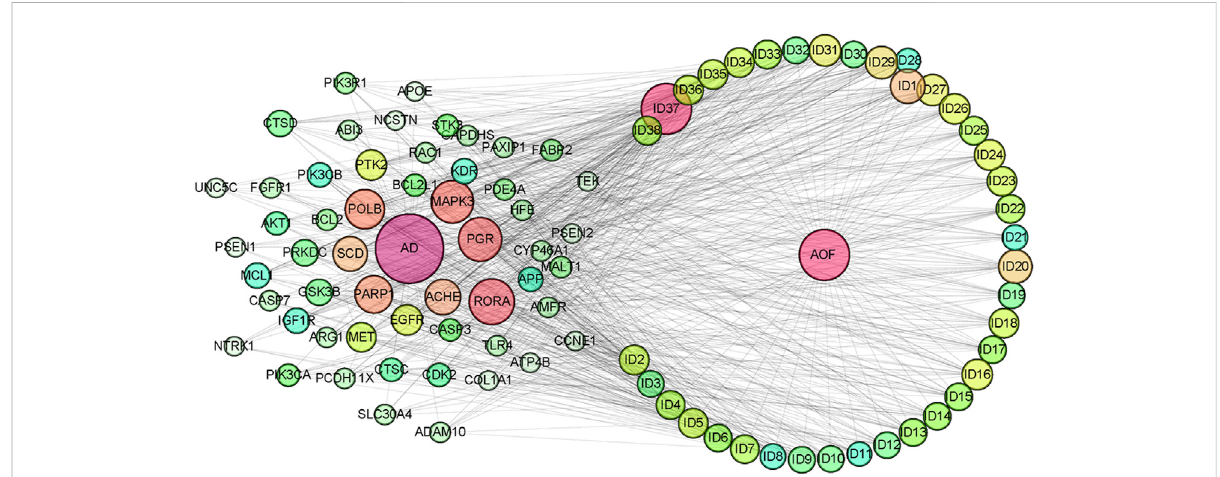
FIGURE 5 Network analysis of potential active compounds in AOF and AD targets. The drug, active compounds, disease and targets were input into Cytoscape to construct the DMTD diagram, and the colors of the nodes are illustrated from red to green in descending order of degree values (ID1: Protocatechuicacid;ID2:OxyphyllaneneA;ID3:OxyphyllenodiolA;ID4:OxyphyllenoneA;ID5:OxyphyllenoneB;ID6:(11S)-Nootkatone-11,12-diol; ID7: Oxyphyllanene B; ID8: Oxyphyllone E; ID9: Oxyphyllone D; ID10: Teuhetenone A; ID11: Cymol; ID12: Oxyphyllenodiol B; ID13: Oplopanone; ID14: 7-Epi-teucrenone; ID15 (5R,7S, 10S)-5-hydroxy-13-noreudesma-4,6-dien-3,11-dione; ID16: Oxyphyllone G; ID17: Teuhetenone B; ID18: Diketone; ID19: 11-Hydroxy-valenc-1 (10)-en-2-one; ID20: Rhamnocitrin; ID21: Dehydronootkatone; ID22: Beta-asarone; ID23: Nootkatol; ID24: Oxyphyllol A; ID25: Oxyphyllenone H; ID26 (4aS, 7S)-7-hydroxy-1,4a-dimethyl-7-(prop-1-en-2-yl)-4,4a,